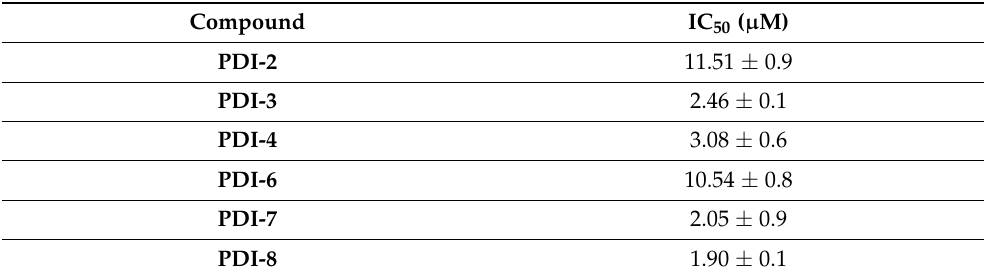
Table 1. IC 50 values of PDI-2 – PDI- 4 and PDI-6 – PDI- 8 incubated for 24 h in HeLa cells.